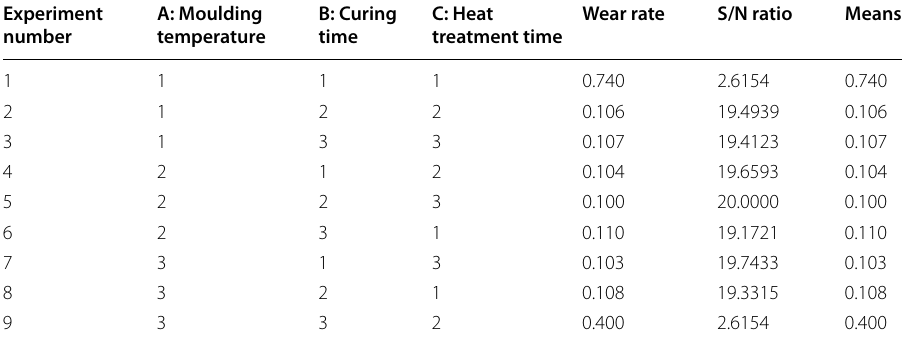
Table 2 Experimental outlay for the wear rate Experiment number